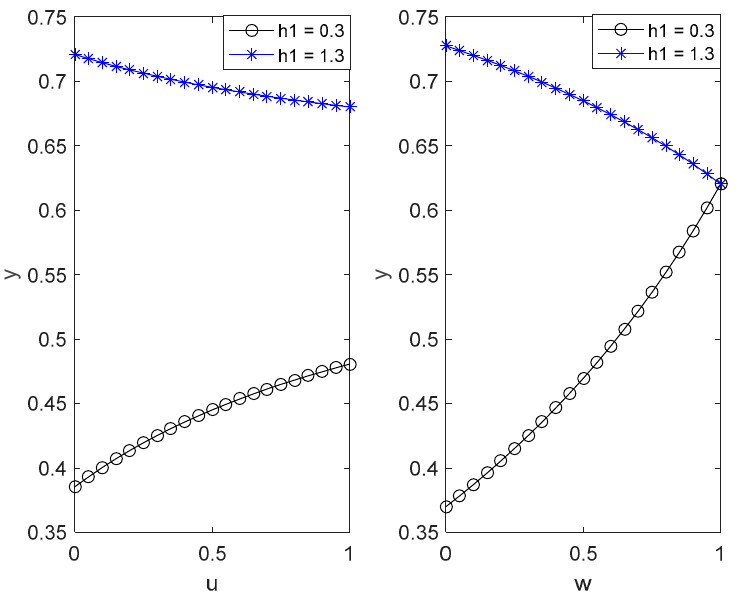
Figure 2. The influence of the external government investment behaviour externality coefficient on local government environmental supervision behaviour.